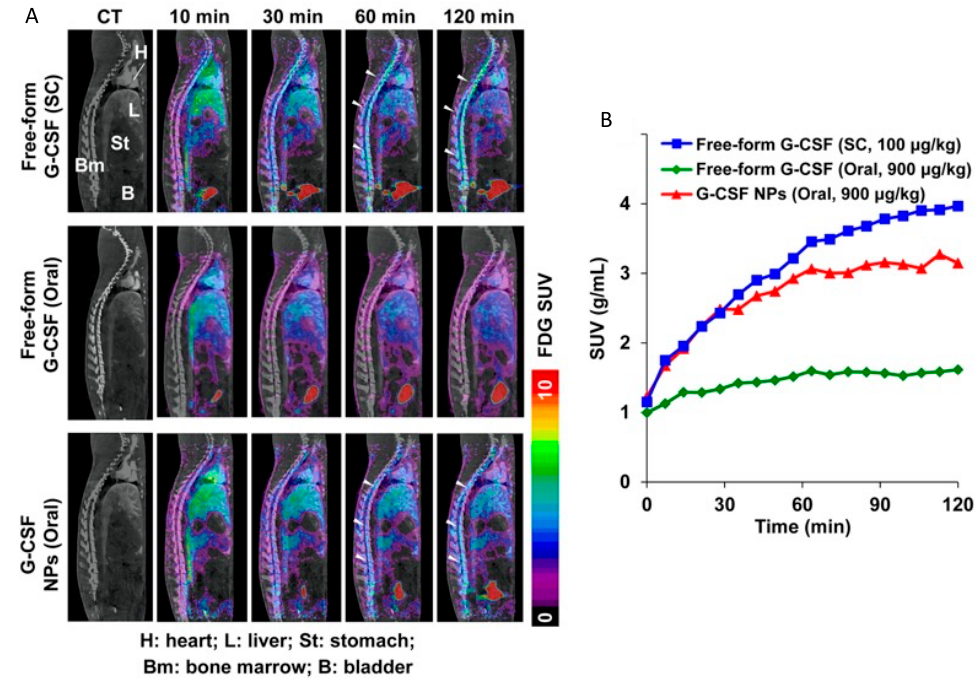
Figure 11. ( A ) PET/CT images show 18 F-FDG accumulation in rats following G-CSF treatment given subcutaneously (SC), orally, or orally within nanoparticles (NPs). ( B ) Radioactive 18 F-FDG concentrations are graphed over 2 h in the bone marrow for the different application modalities. Reprinted with permission from Su et al. (2014) [107,128].